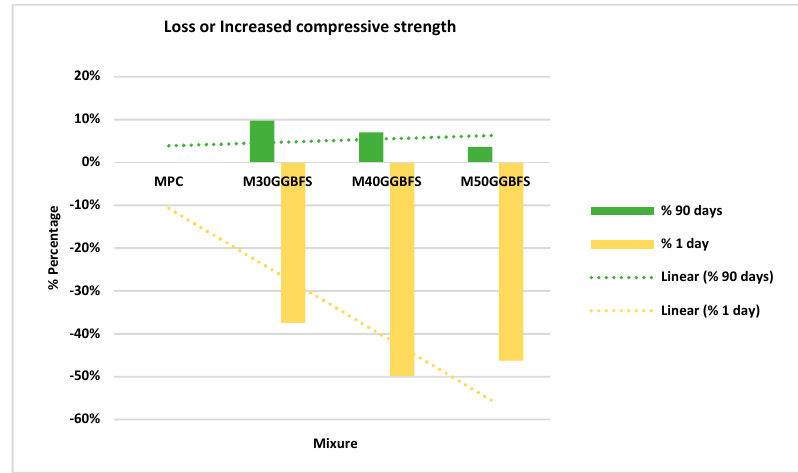
Figure 4. Percentage of loss or increase in compressive strength GGBFS.